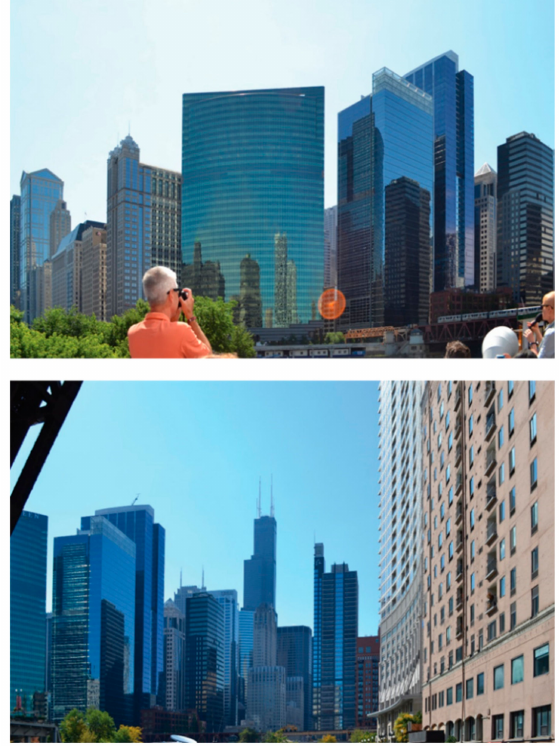
Figure 12. One of the most spectacular spots along the Chicago River is the river confluence where its three branches meet. As the boat turns, riders stand and take photographs of tall buildings surrounding this